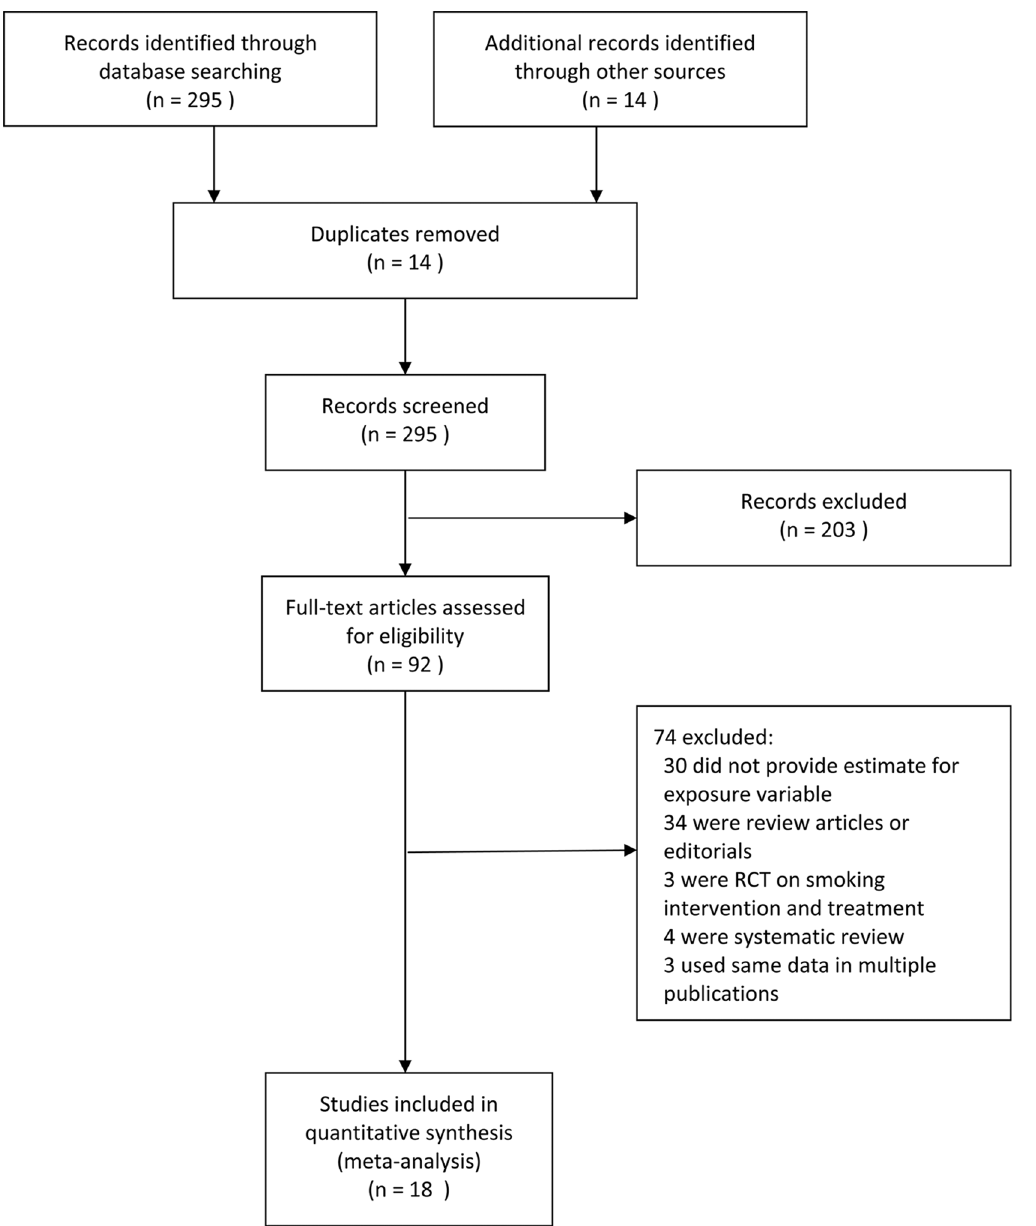
Fig 1. Flowchart of study identification and inclusion. RCT, randomized controlled